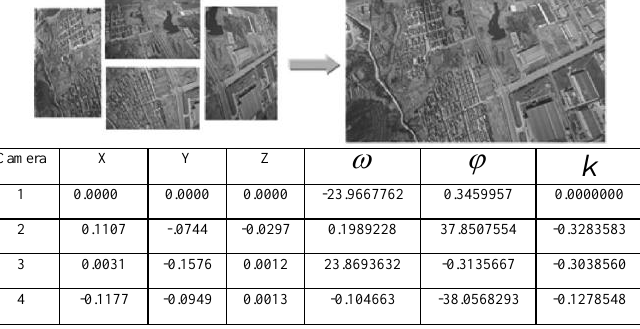
Figure 11. The four-combined equipment image